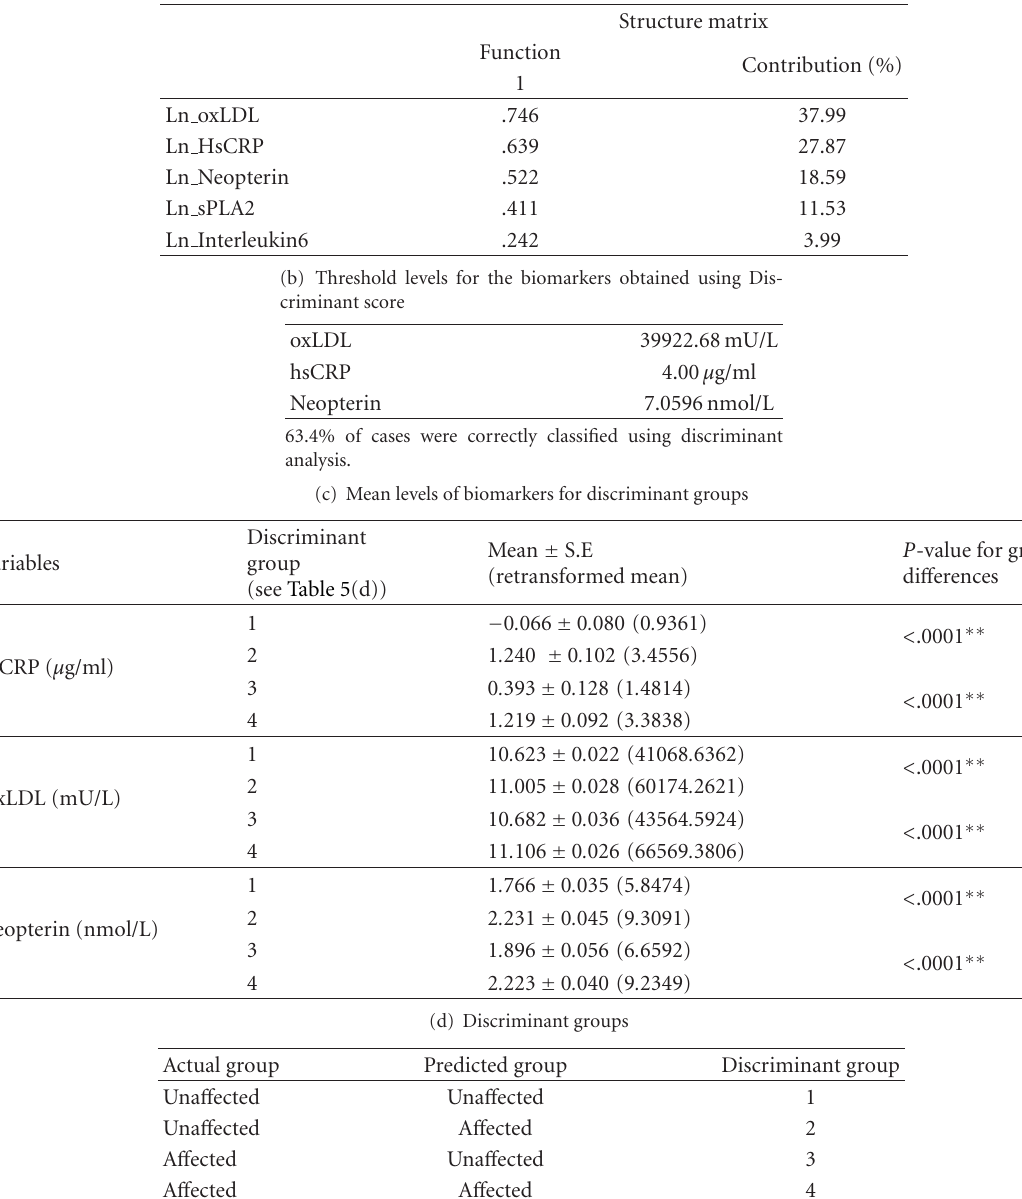
(a) Discriminant analysis